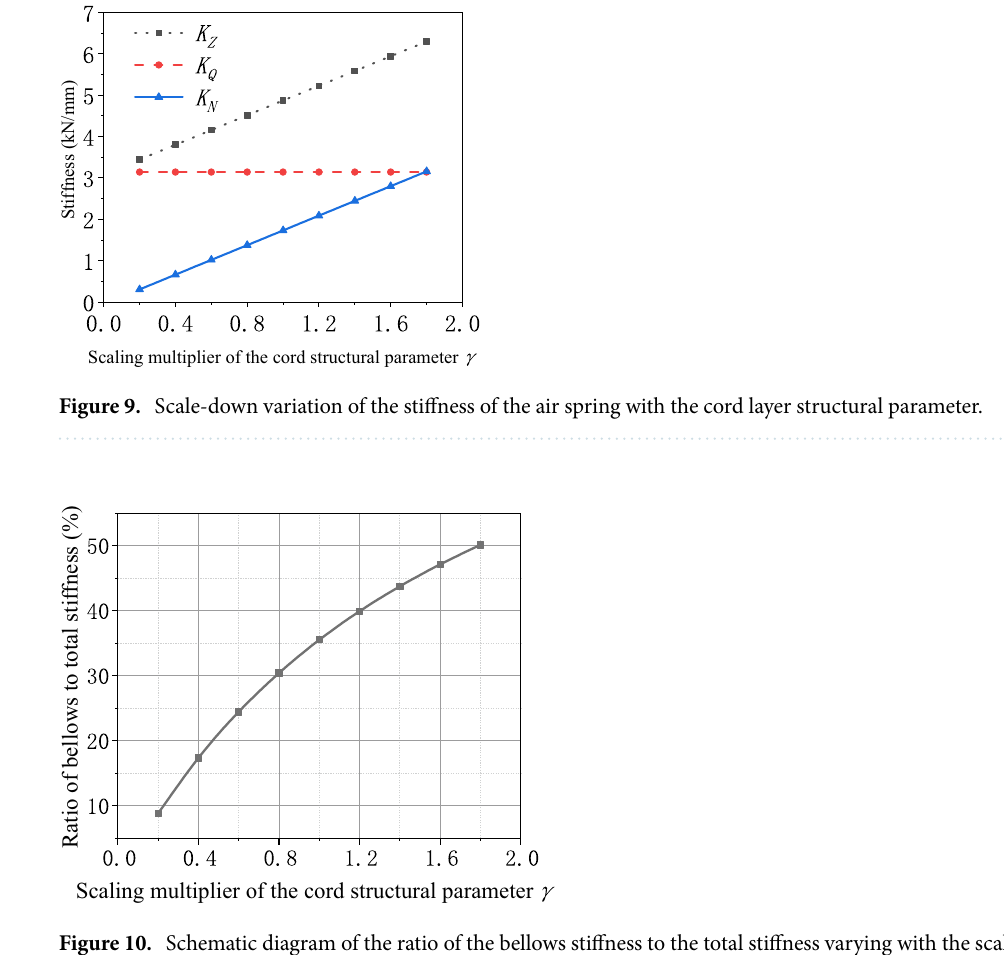
Figure 10. Schematic diagram of the ratio of the bellows stiffness to the total stiffness varying with the scale- down of the cord layer structural